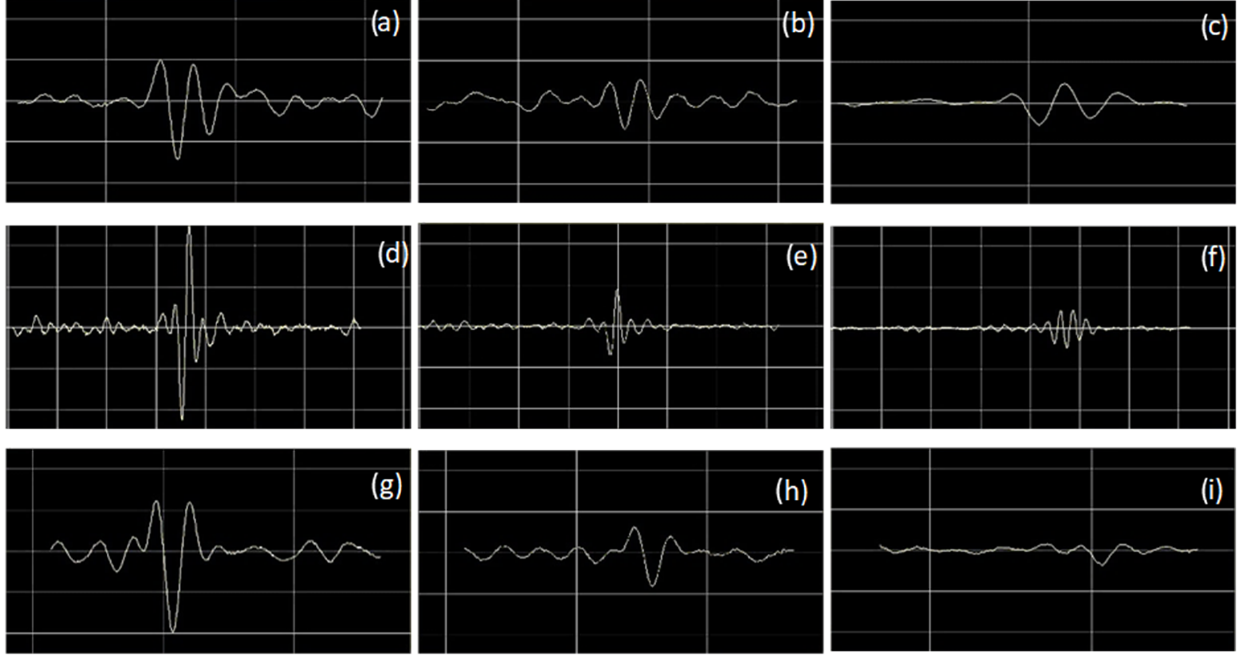
Figure 7. A-Scans obtained for: ( a ) weld root notch at 18 °C, ( b ) weld root notch at 122 °C, ( c ) weld root notch at 200 °C, ( d ) weld toe notch at 18 °C, ( e ) weld toe notch at 120 °C, ( f ) weld toe notch at 203 °C, ( g ) lack of fusion at 18 °C, ( h ) lack of fusion at 120 °C, and ( i ) lack of fusion at 201 °C.